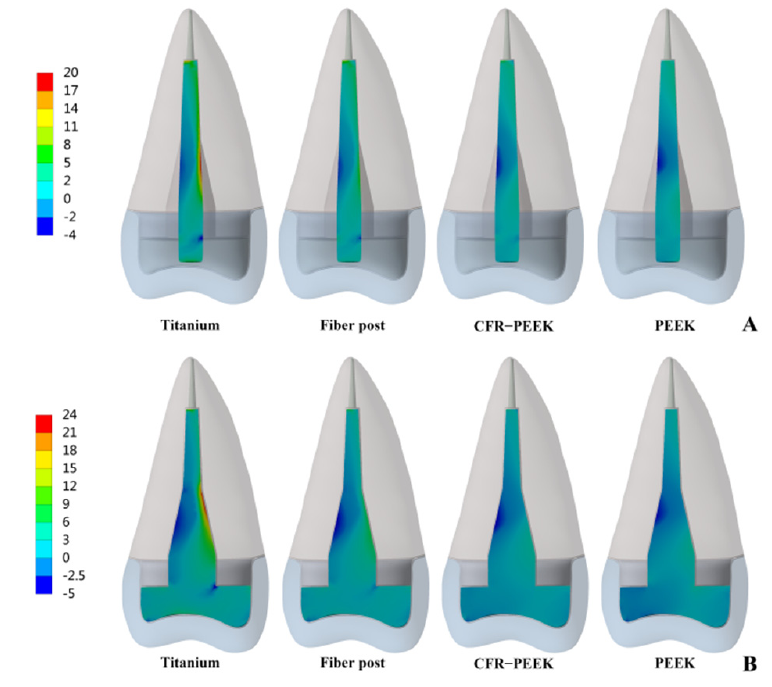
Figure 7. Distributions of MPS at post. ( A ) Prototype 2. ( B ) Prototype 3.